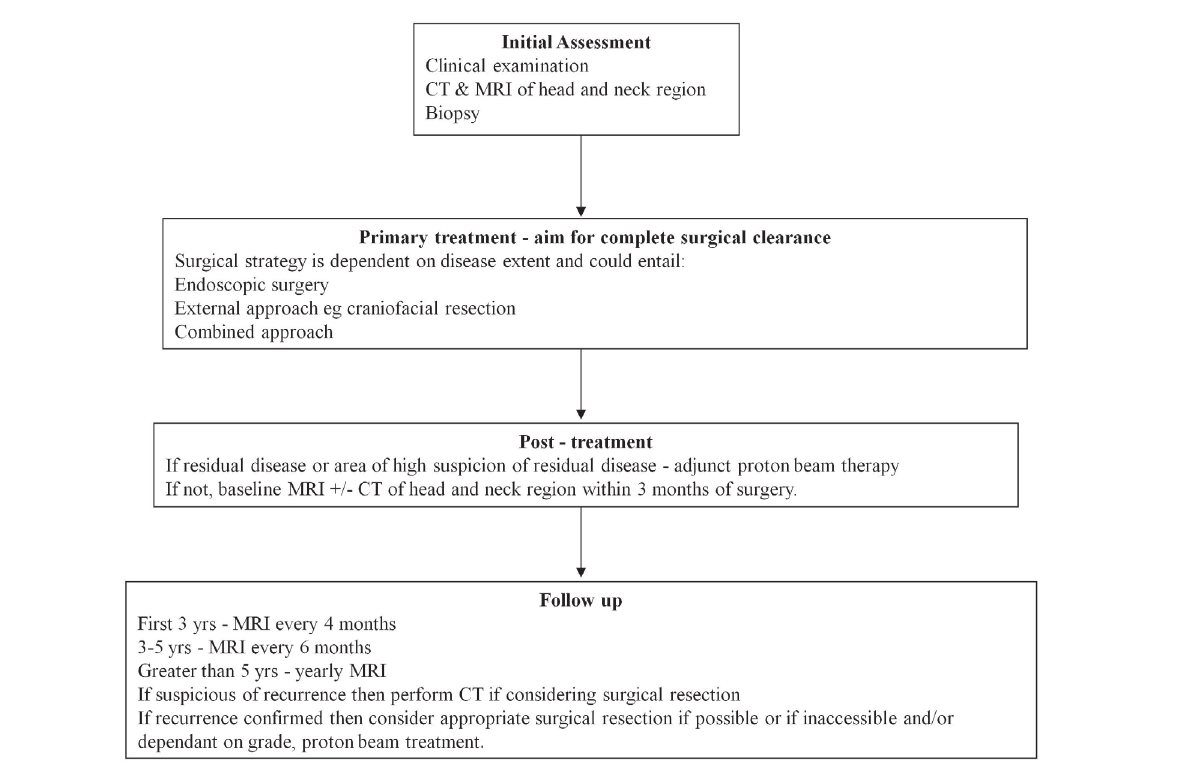
Figure 1. Proposed management algorithm for non-mesenchymal chondrsarcomaof the sinonasaland skull base region (modified from Lund et al. (81)